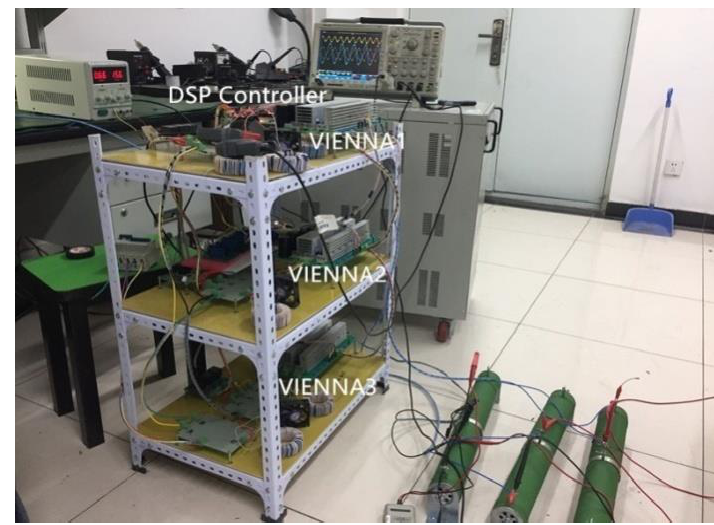
Figure 11. Experimental platform.